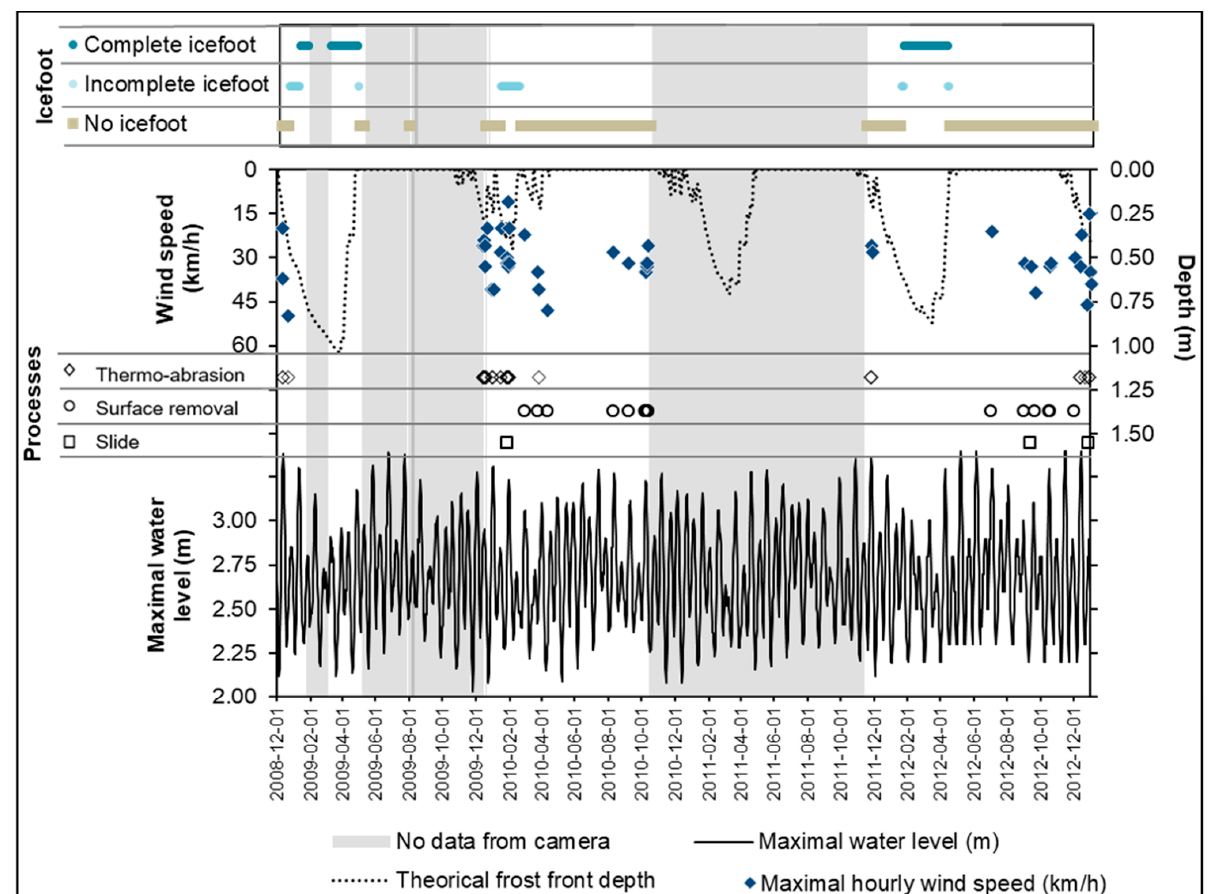
Figure 17. Chronology of the different hydrodynamic erosion events in relation to the processes, the wind speed, the tide cycle, and the frost front depth.